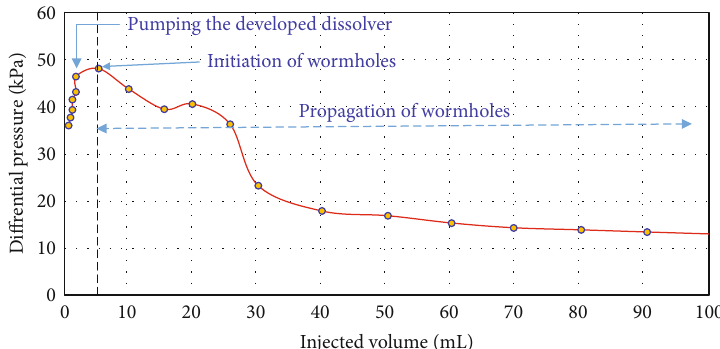
Figure 8: Pressure drop versus injected volume during injecting with the developed dissolver.